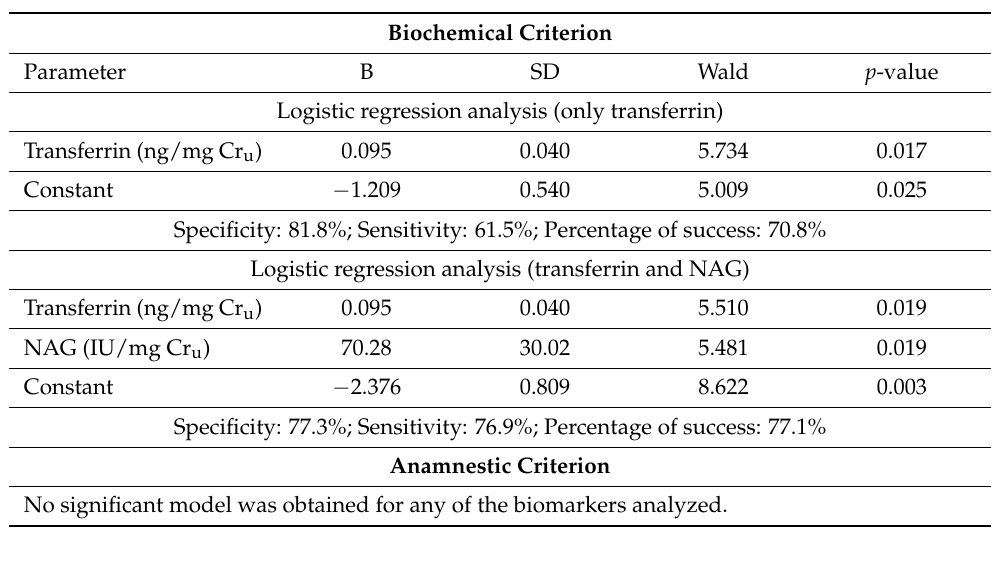
Figure 8. Summary of the etiological diagnostic capacity of urinary injury biomarkers (according to the area under the ROC curve) following pre-renal/renal classification by biochemical and anamnestic criteria. Color key: yellow, p < 0.05; orange, p < 0.01; green, p < 0.001; white, p > 0.05. Table 2. Best logistic regression models for etiological (i.e., pre-renal and renal) AKI diagnosis based on urinary biomarkers. Cr u : urinary creatinine concentration. NAG: N-acetylglucosaminidase.